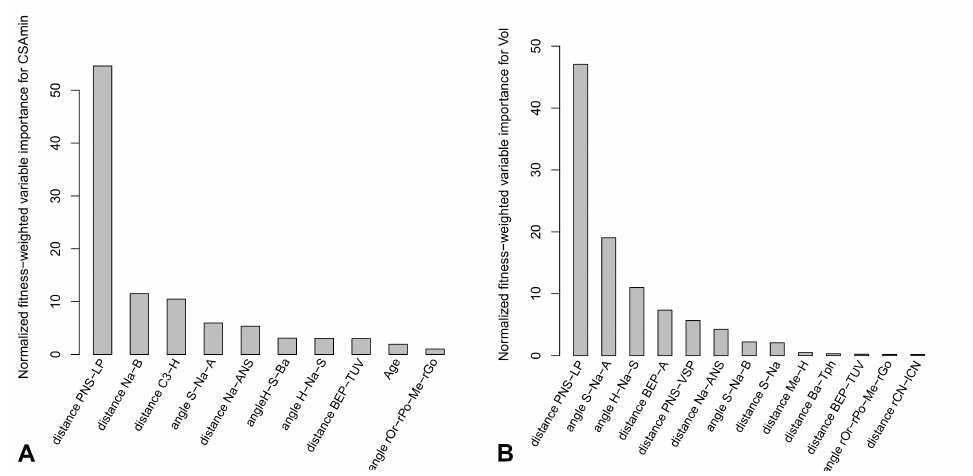
Figure 3. Results for the symbolic regression analysis. ( A ) The variables are ranked by decreasing normalized fitness-weighted variable importance to explain the CSAmin of the upper airway. ( B ) The variables are ranked by decreasing normalized fitness-weighted variable importance to explain the volume (Vol) of the upper